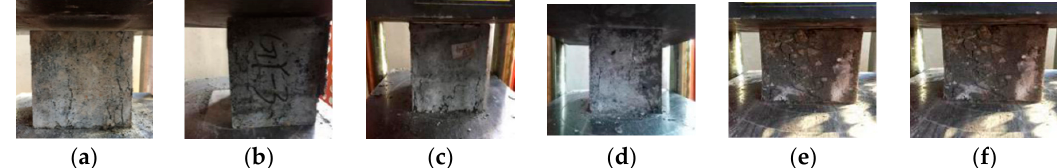
Figure 11. Compressive strength failure mode of hybrid polypropylene-steel fiber RPC: ( a ) 0%, ( b ) 1%, ( c ) 1.25%, ( d ) 1.5%, ( e ) 1.75 and ( f ) 2%.